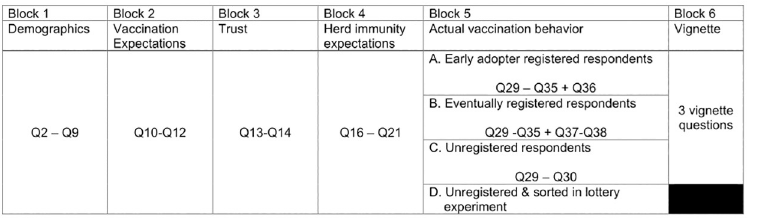
Fig 1. Survey flow. Respondents answered questions in Block 1 to Block 5 before reporting their vaccination registration status. Individuals who reported their willingness to share personal information and were yet to be registered into the national vaccination program were sorted in an experiment. Personal information was excluded and destroyed in data analysis process. The remaining respondents—i.e. those who had registered for vaccination, those who had been vaccinated, and unregistered individuals who were not willing to share personal information- proceeded to the parts of the survey that explored their reasons for taking up or refusing vaccination. These respondents then randomly sorted into 1 of 4 different vignettes. In each vignette, respondents were provided their expectations on a third party’s vaccination behaviour and government policies to increase take-up levels of vaccination were